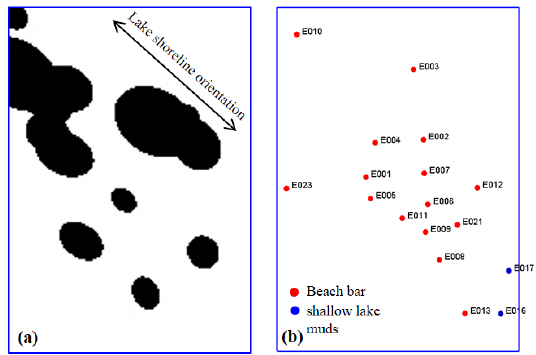
Figure 17. Training images and well point hard data of facies modeling of SC2 layer in E area of Xinjiang Oilfield. ( a ) Training images; ( b ) well point hard data.